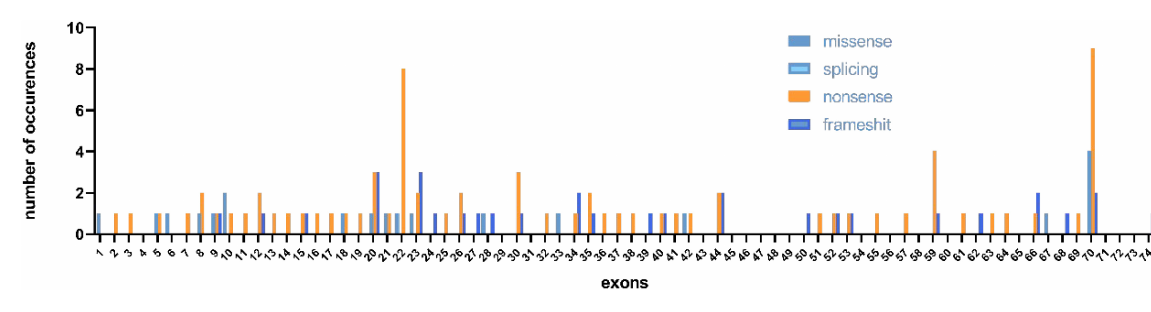
FIGURE1 Distribution of exons of small mutations in different mutation types.